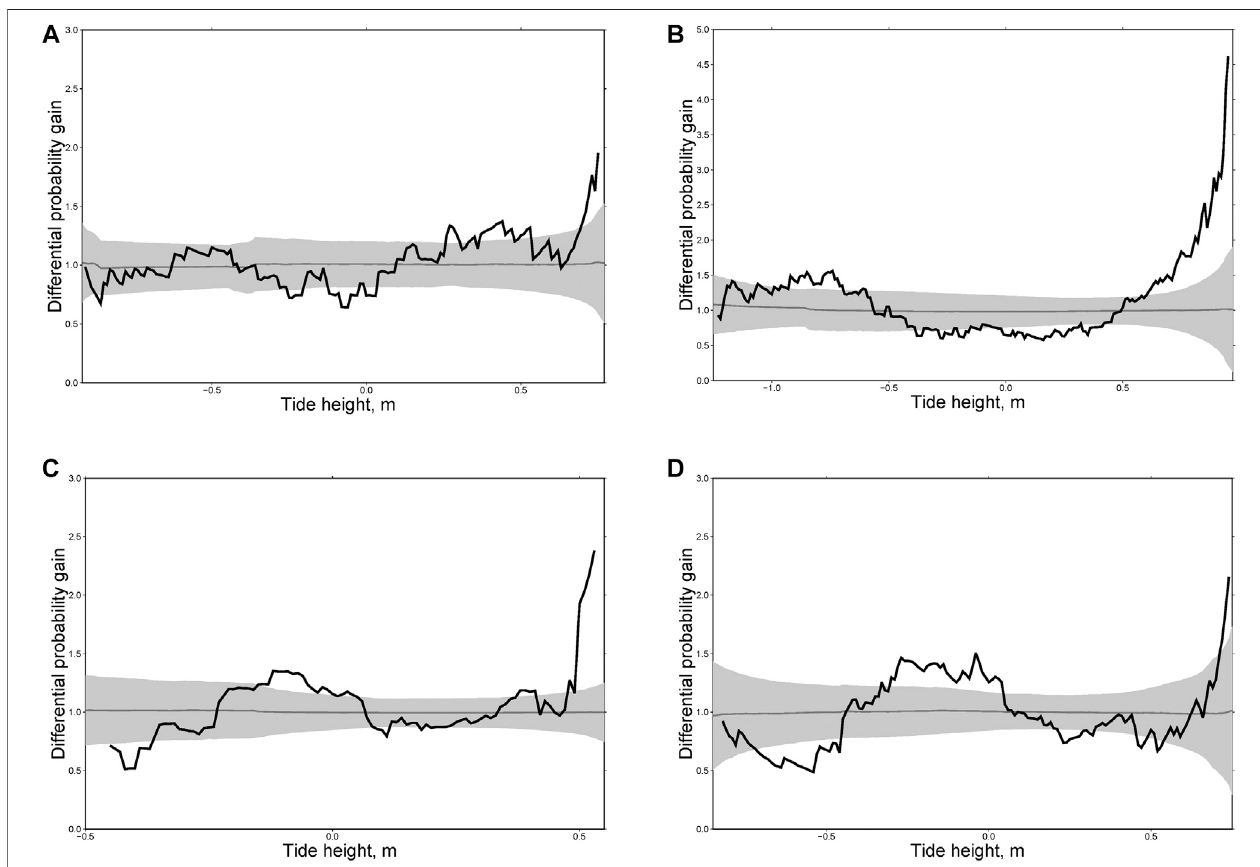
FIGURE 7 | Differential probability gain functions for four aftershock sequences for Kamchatka following the earthquakes of M (cid:1) 6.7, December 28, 1984 (A) ; M (cid:1) 6.3, July 10, 1987 (B) ; M (cid:1) 6.8, March 2, 1992 (C) ; M (cid:1) 6.8, February 28, 2013 (D) . Solid line shows values of g, the straight line marks the level 1.0.